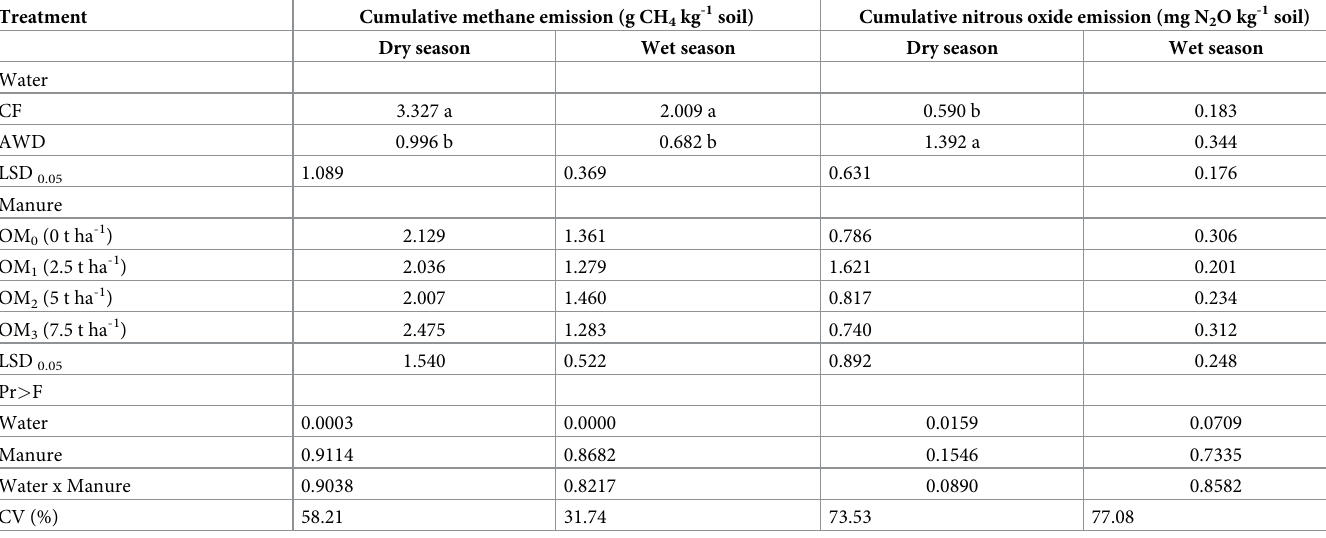
Within each column, values with different alphabets indicate significant differences among the treatments at 5% of LSD